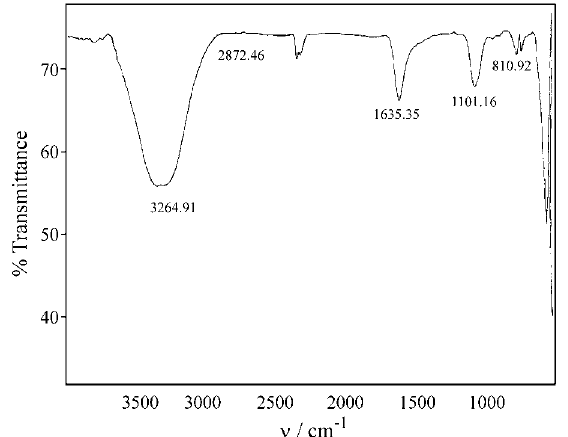
Figure 5b. Espectro IR característico de una disolución de Al 2 (SO 4 ) 3 0.1 molar, correspondientes a muestras líquidas obtenidas del filtrado del